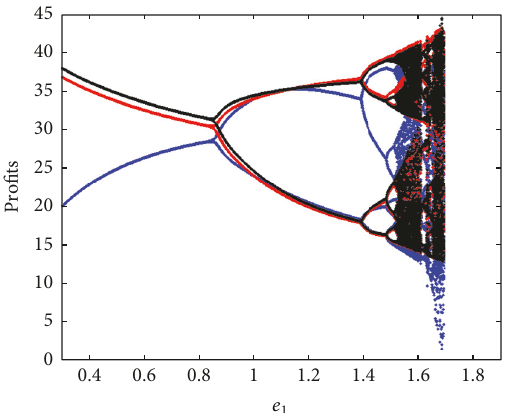
Figure 19: Effects of 𝑒 1 on profits, 𝛼 = 0.2 , 𝛽 = 0.2 , and 𝛾 = 0.2 . Chaos in the economic systems is harmful to all the